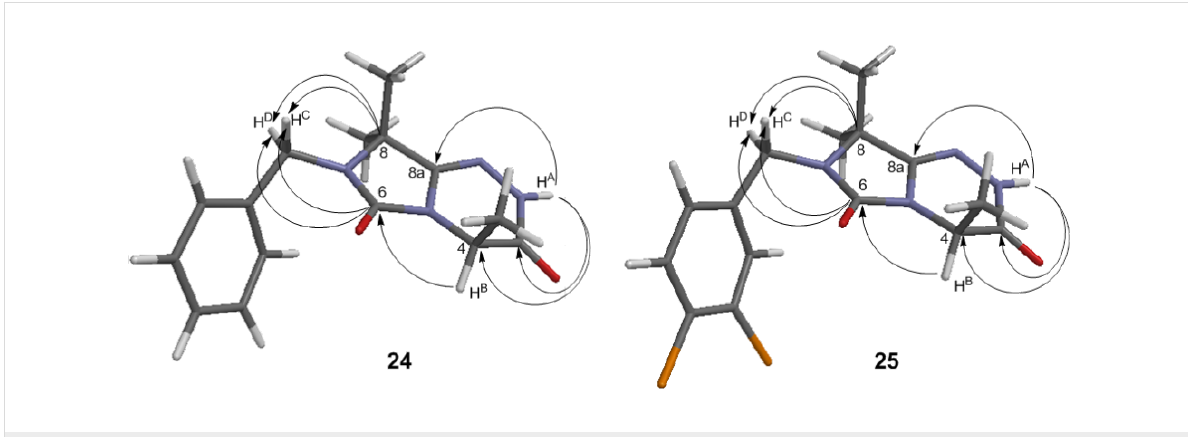
Figure 2: Optimized structure (MMFF95) and key HMBC correlations of imidazo[5,1- c ][1,2,4]triazine-3,6(2 H ,4 H )-diones 24 and 25 .